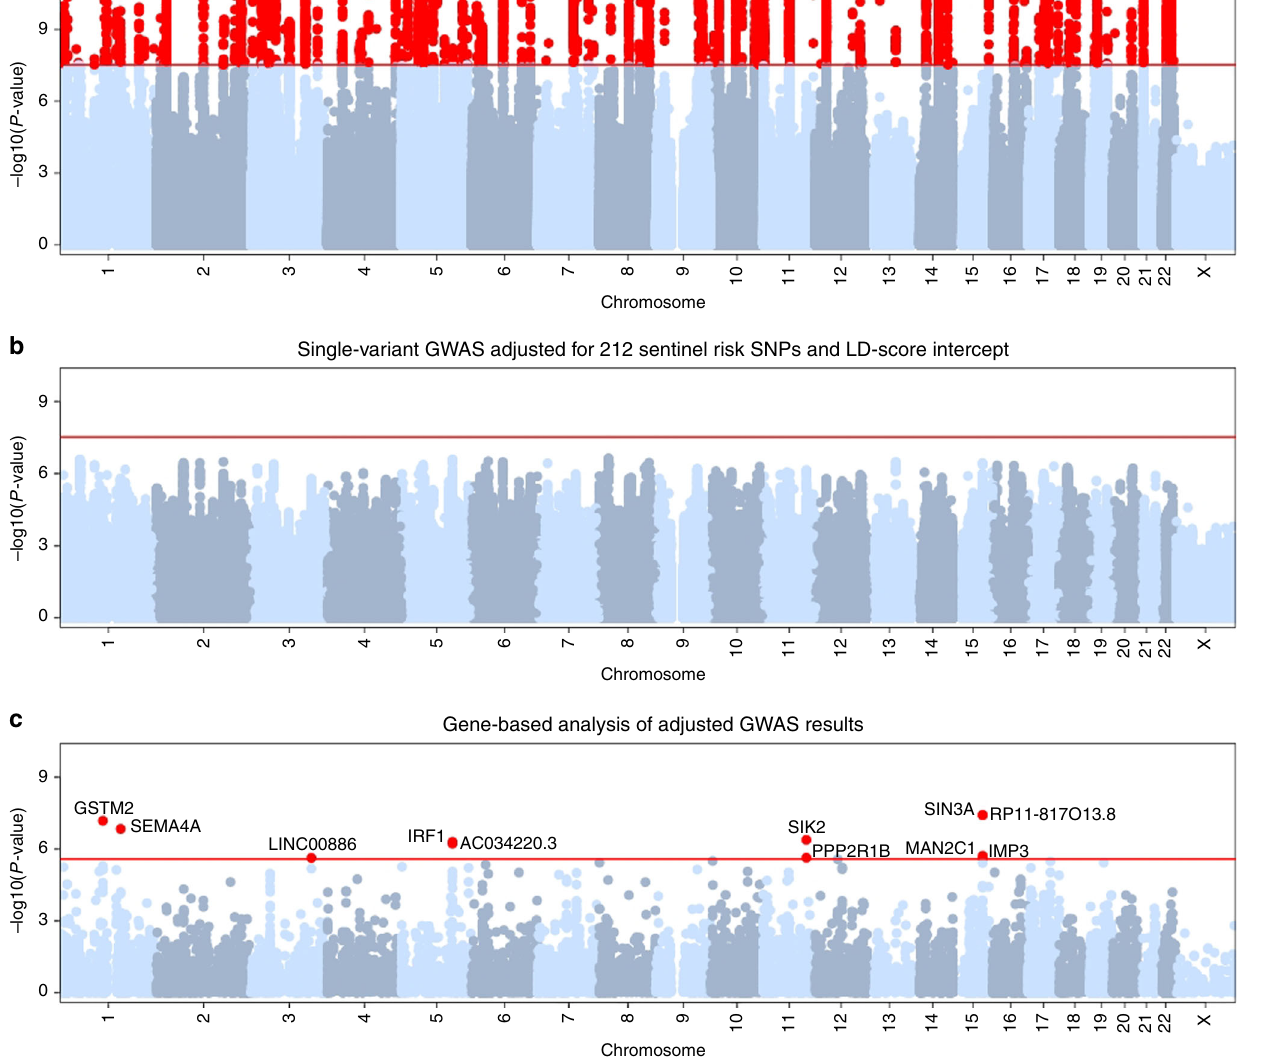
Fig. 2 Manhattan plots summarizing association results for overall breast cancer. a Association results ( − log 10 of the P -value obtained using an inverse- variance meta- analysis) from the single-variant GWAS originally reported by Michailidou et al. 2 . b Single-variant GWAS adjusted for 212 sentinel risk variants and LD-score intercept; P -values were obtained with the GCTA-COJO joint analysis. c Gene-based analysis of adjusted GWAS results; P -values were obtained with the EUGENE gene-based test of